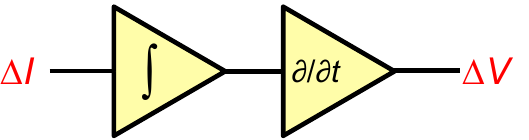
Figure 24. A two-stage integrator/differentiator amplification method for nanopore signals.